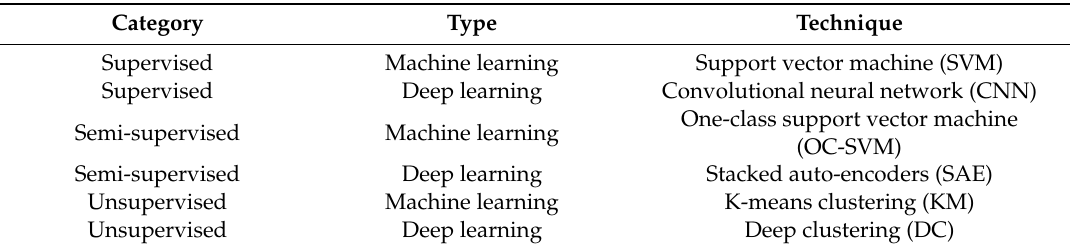
Table 1. Machine learning (ML) and deep learning (DL) techniques compared in this study.